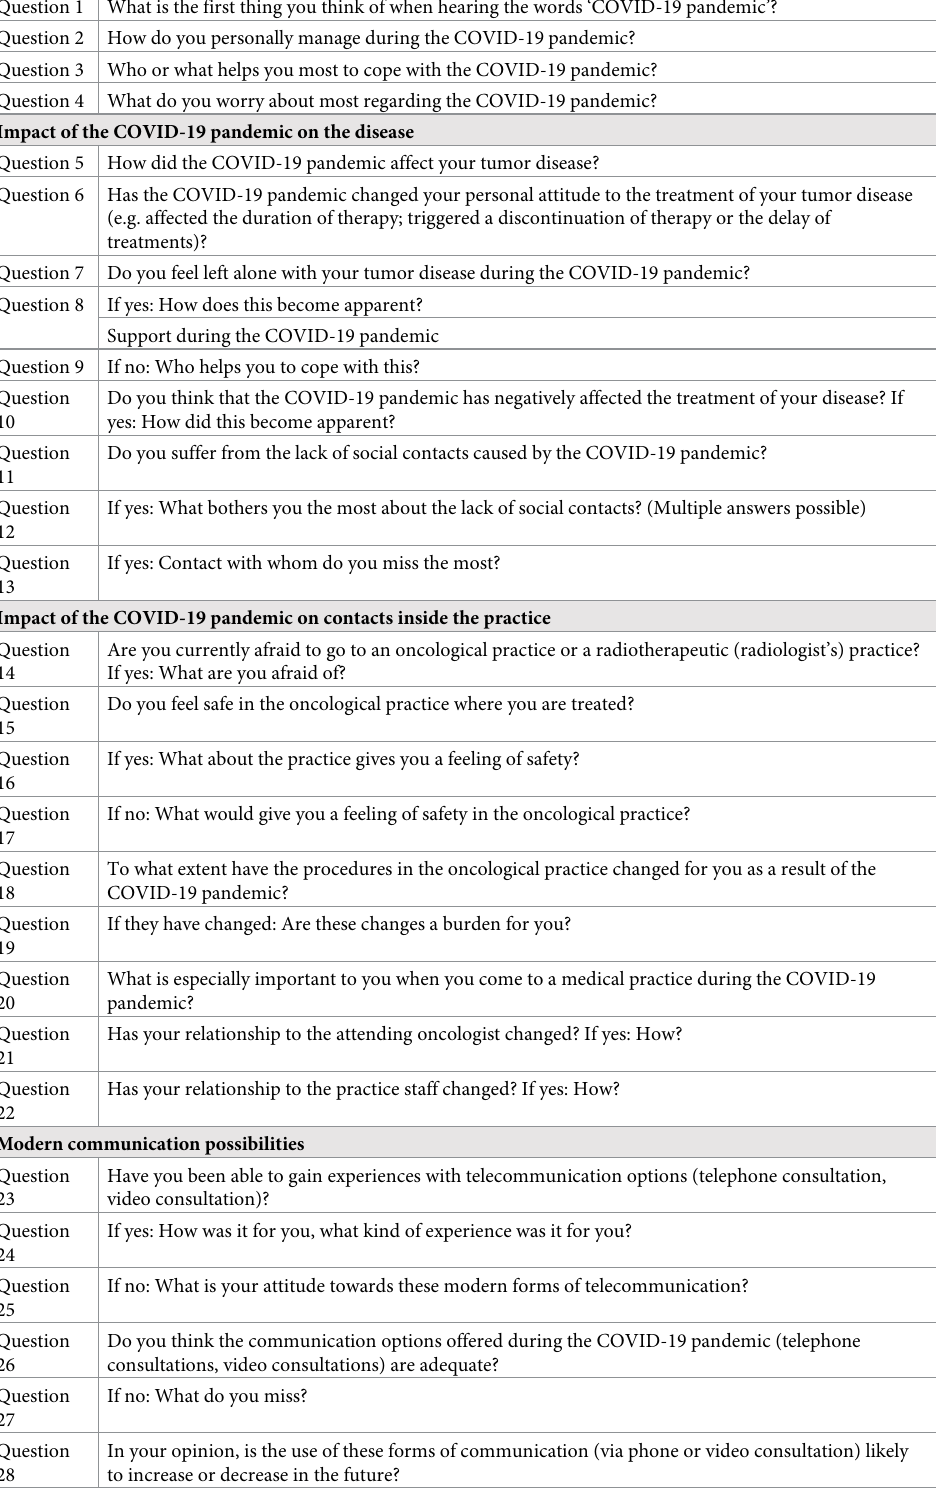
Table 1. Interview guide for tumor patients. Personal handling of the COVID-19 pandemic Question 1 What is the first thing you think of when hearing the words ‘COVID-19 pandemic’? Question 2 How do you personally manage during the COVID-19 pandemic? Question 3 Who or what helps you most to cope with the COVID-19 pandemic? Question 4 What do you worry about most regarding the COVID-19 pandemic? Impact of the COVID-19 pandemic on the disease Question 5 How did the COVID-19 pandemic affect your tumor disease? Question 6 Has the COVID-19 pandemic changed your personal attitude to the treatment of your tumor disease (e.g. affected the duration of therapy; triggered a discontinuation of therapy or the delay of